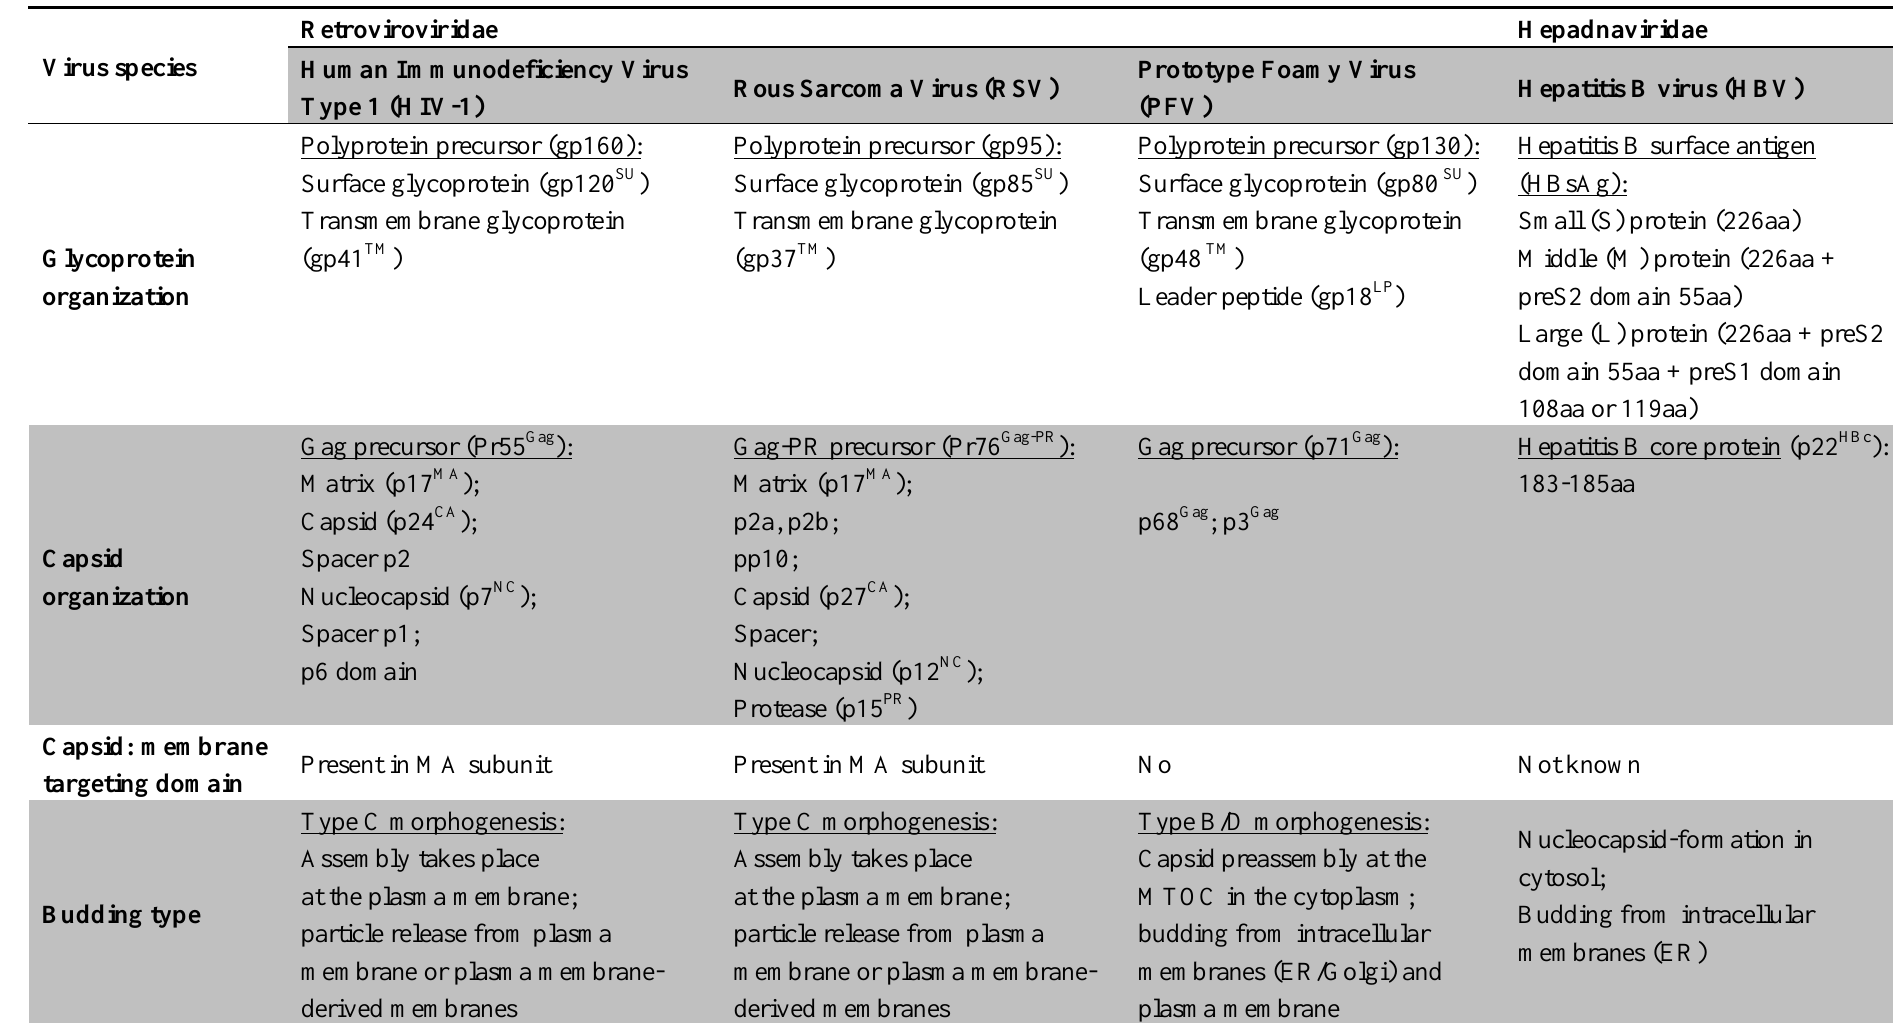
Table 1. Features of HIV-1, RSV, PFV and HBV budding